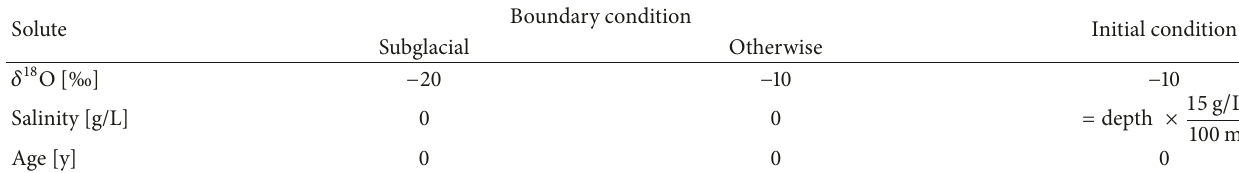
Table 3: Solute transport initial and boundary conditions.